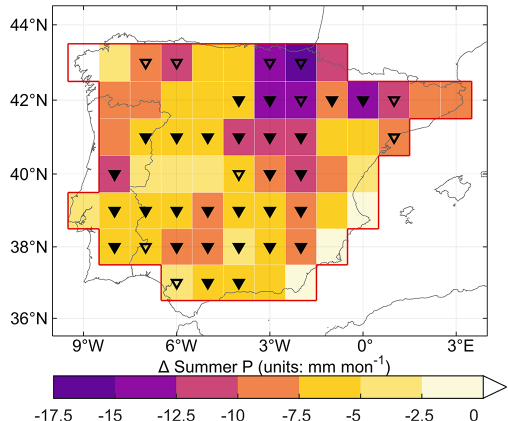
Figure 3. The difference of average summer precipitation over the IP between 1998–2019 and 1980–1997 (average of 1998–2019 mi- nus average of 1980–1997). The triangles indicate that the differ- ences are significant at the 0.05 (solid) and 0.1 (hollow)